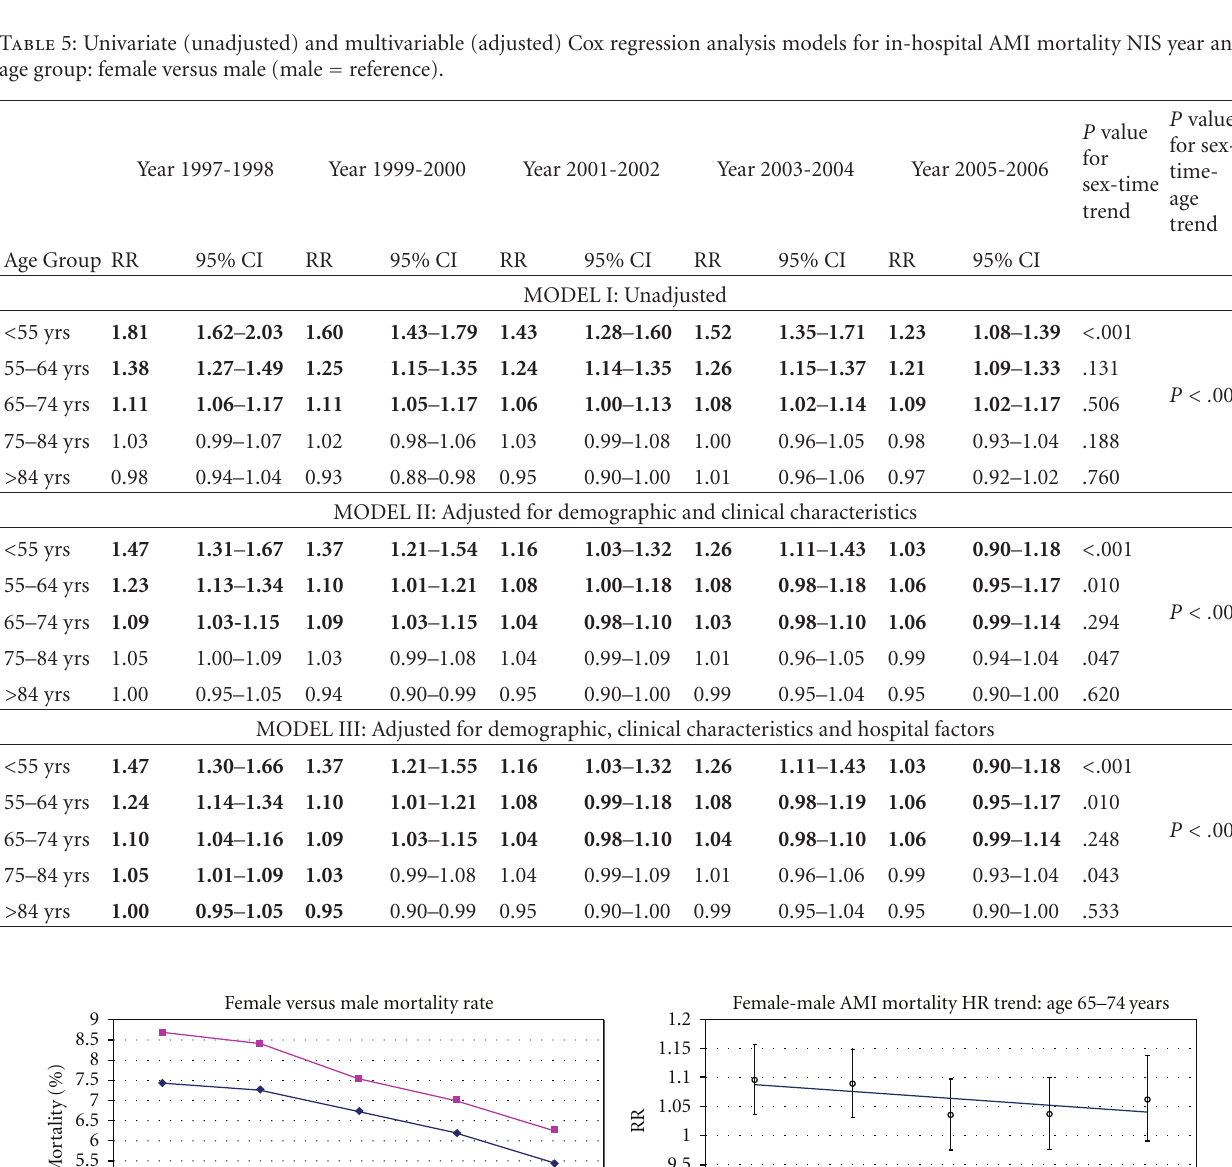
relative to latter time points, hence the adjustment did not account for the di ff erential sex e ff ect across time.